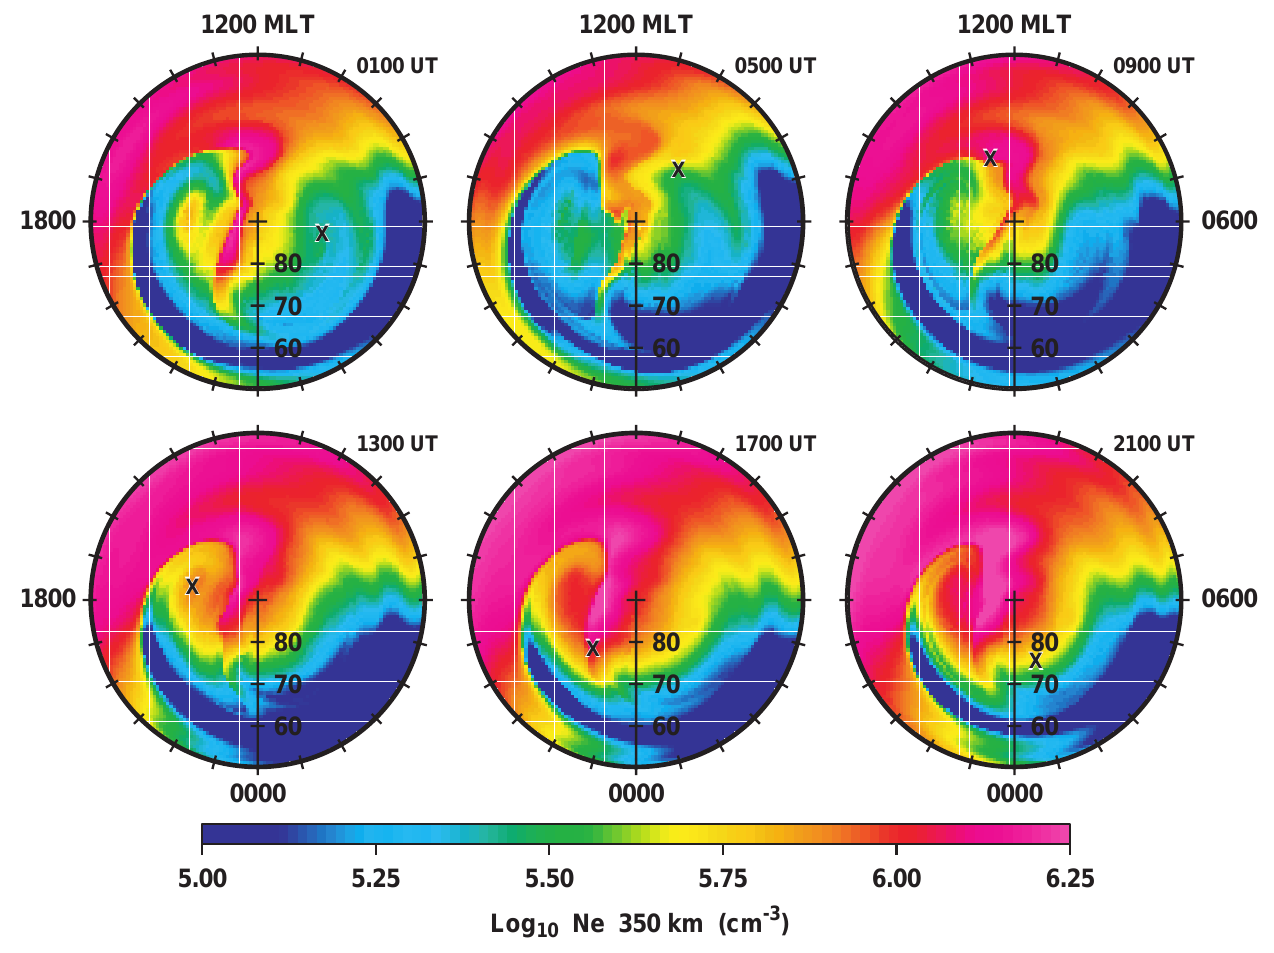
Fig. 6. Six snapshots of simulated electron density at 350km at 4 hourly intervals from the no-wind TDIM study for 8 October 2002 (day 281). Each panel shows the logarithm of electron density, as well as an X marking the location of Longyearbyen in an MLT-magnetic latitude coordinate